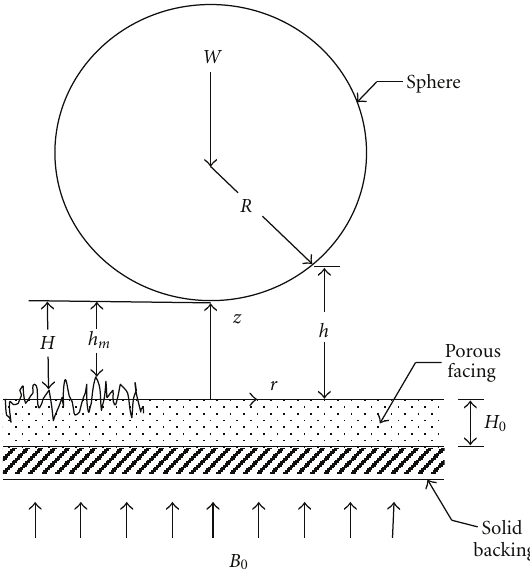
Figure 1: Squeeze-film geometry between a sphere and a porous plane surface with roughness in the presence of a transverse magnetic field.